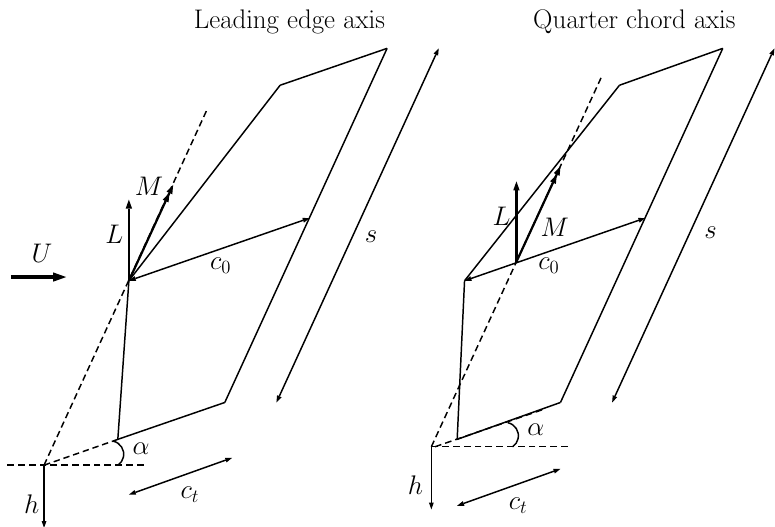
Figure 4. Tapered wing with pitch axis at the leading edge and quarter